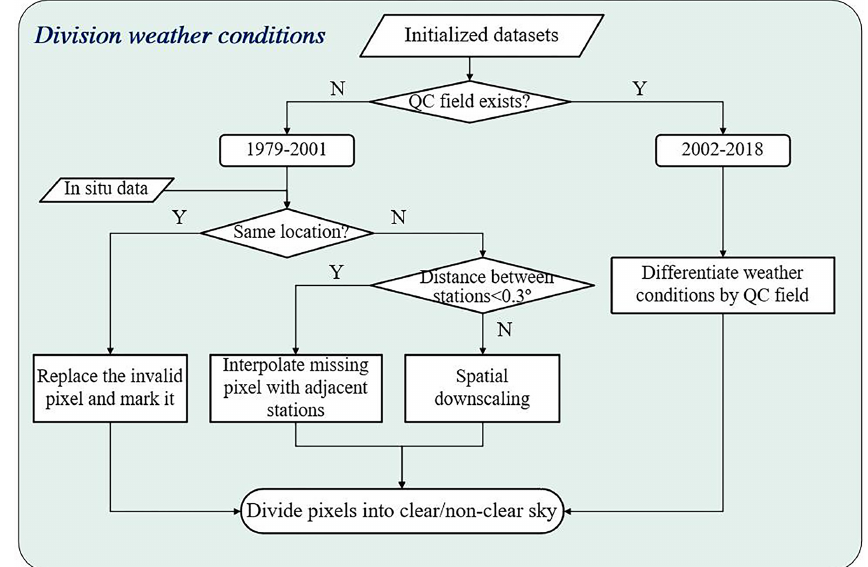
Figure 3. Summary flowchart for classification of weather